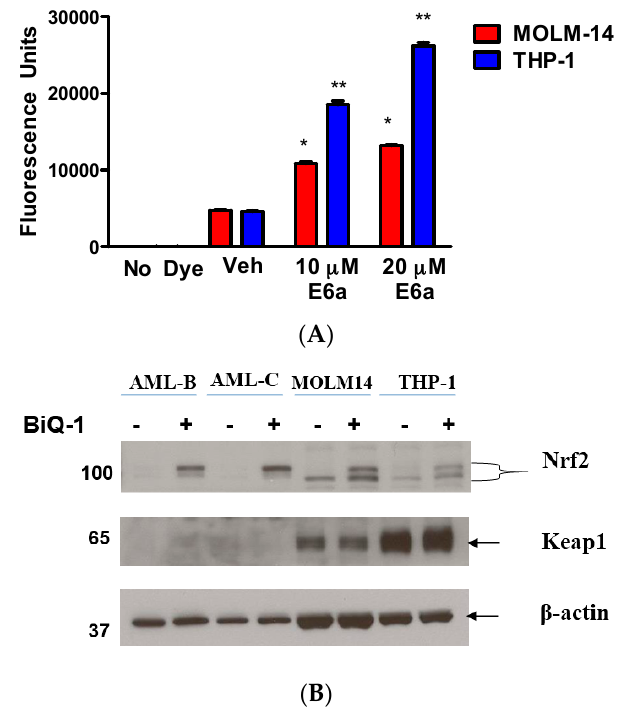
Figure 4. BiQ-1 treatment increased cellular ROS levels in AML cells. ( A ) MOLM-14 and THP-1 cells were loaded with H 2 DCFA dye for 30 min and then exposed to 10 and 20 µM of BiQ-1 for 2 h. Both cell lines displayed a significant increase in ROS (* p < 0.00001; ** p < 0.00001); ( B ) Nrf2 and Inrf2/Keap1 induction after exposure to BiQ-1. MOLM-14 and THP-1 cell lines were treated with 5 µM BiQ-1 for 2 h.